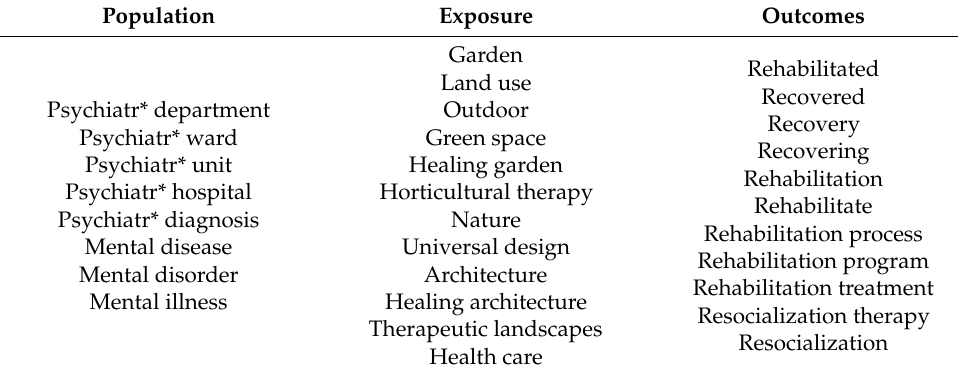
Table 1. Search terms. Population Exposure